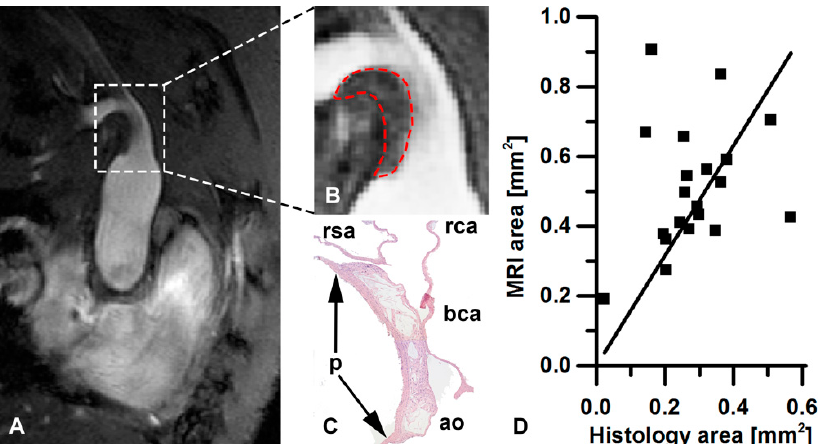
Figure 5. Comparison of MRI and histology. ( A ) T 1 -weighted anatomical reference image of BCA view and ( B ) enlarged view with enhanced contrast of plaque region with ROI (dashed red line). ( C ) Plaque region of the same mouse as observed on HE-stained histology. ao = aortic arch; bca = BCA; rca = right carotid artery; rsa = right subclavian artery; p = atherosclerotic plaque (extends between arrows). ( D ) Scatterplot of plaque area on MRI versus plaque area on HE-stained histology. The solid line represents the linear fit of the data ( R 2 = 0.87).